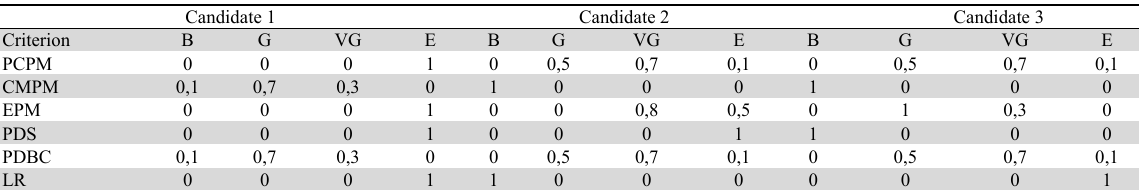
Results of candidate